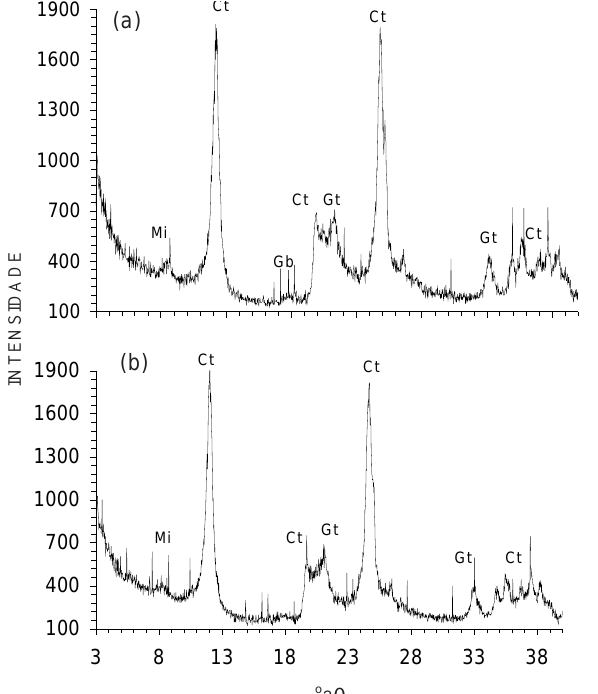
Figura 3. Difratogramas de raios-X da fração argi- la orientada do horizonte B do PVAe da Forma- ção Adamantina (amostra 3), mostrando a mi- neralogia antes (a) e depois do estudo de cinética (1.382 h de contato com ácido cítrico 0,1 mol L -1 ) (b): Ct - caulinita, Gt - goethita e Mi -